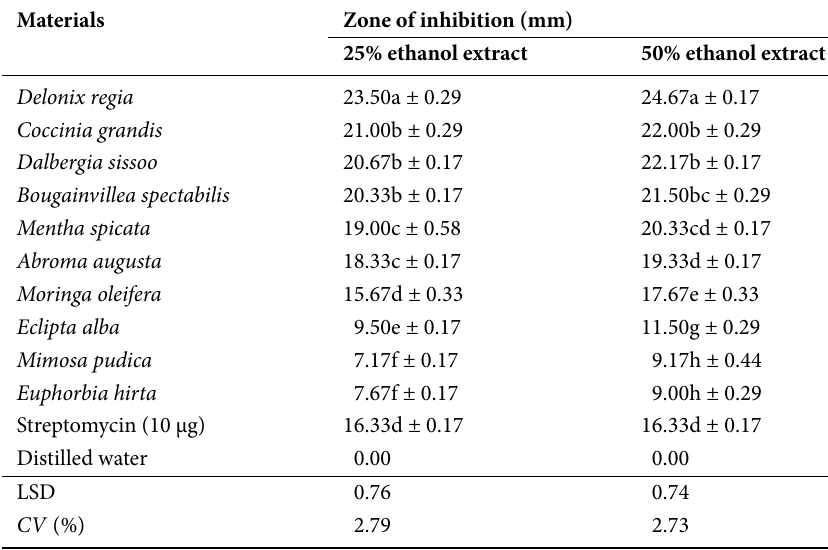
Table 3 Antibacterial activity of ethanol extracts of 10 medicinal plants (zone of inhibition in